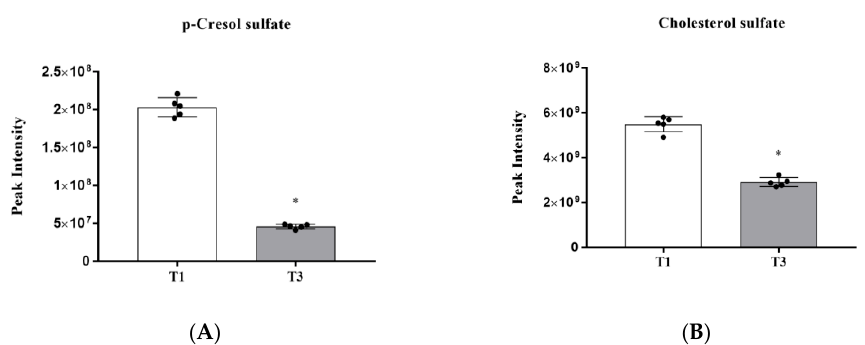
Figure 2. Differential metabolites from T1 group vs. T3 group. ( A ) p-Cresol sulfate and ( B ) Cholesterol sulfate. T1: the broilers were fed a basal diet; T3: the broilers were fed a basal diet supplemented with AGE at 0.4%. * p < 0.05.